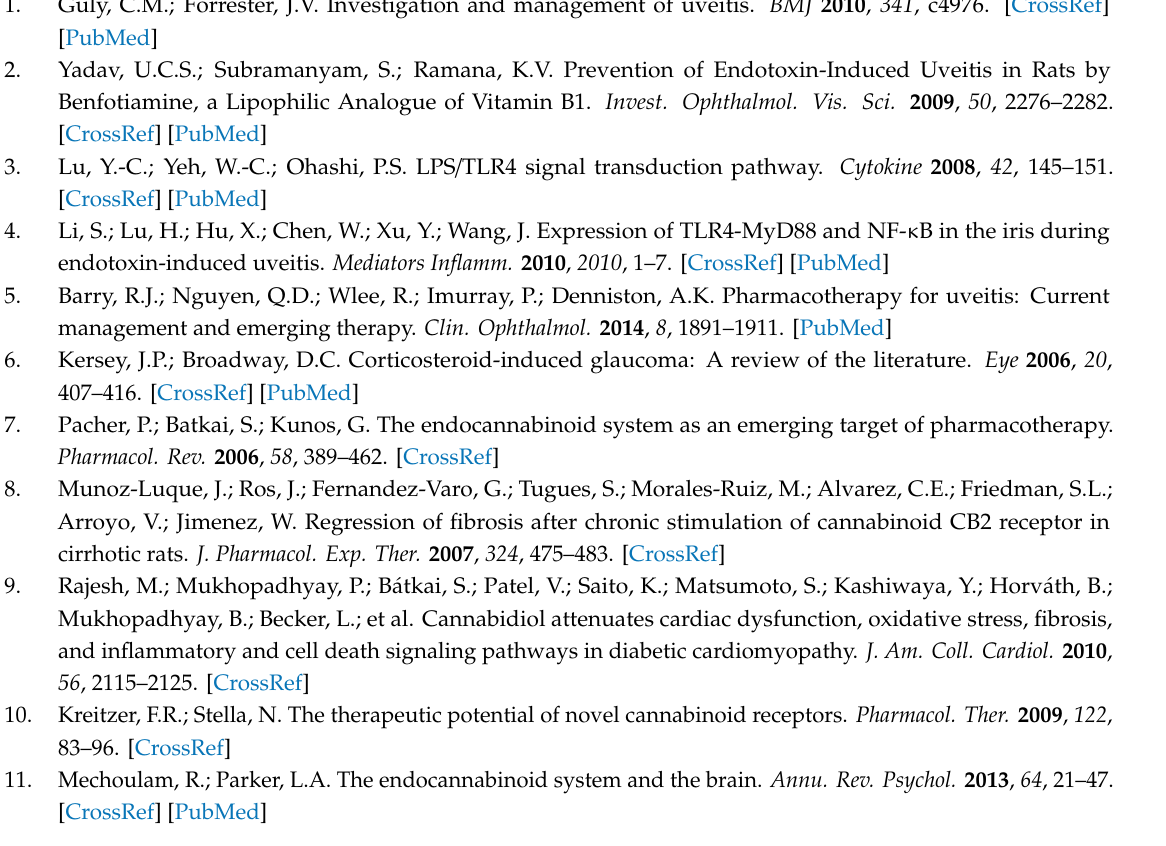
Figure S1: Overlay of the docking poses from CB 2 R ligands within the binding cavity of the inactive-state CB 2 R X-ray structure, Figure S2: Dose response for the CB 2 R agonist, HU910, Figure S3: Gr-1 antibody neutrophil depletion, Figure S4: Neutrophil depletion and leukocyte adhesion during EIU, Table S1: Physicochemical and early absorption, distribution, metabolism, excretion, and toxicology properties, Table S2: Solubility of CB 2 R ligands in selected solvents, Table S3: Mouse pharmacokinetic profiles of CB 2 R ligands, Table S4: Leukocyte-endothelial rolling during EIU and treatment with CB 2 R